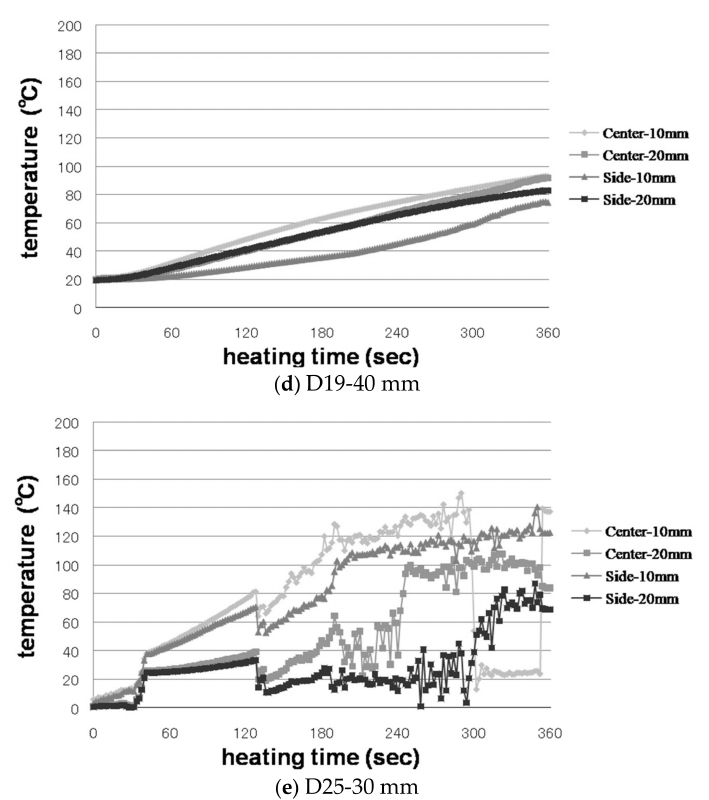
Figure 5. Increase in temperature with time in reinforced concrete during induction